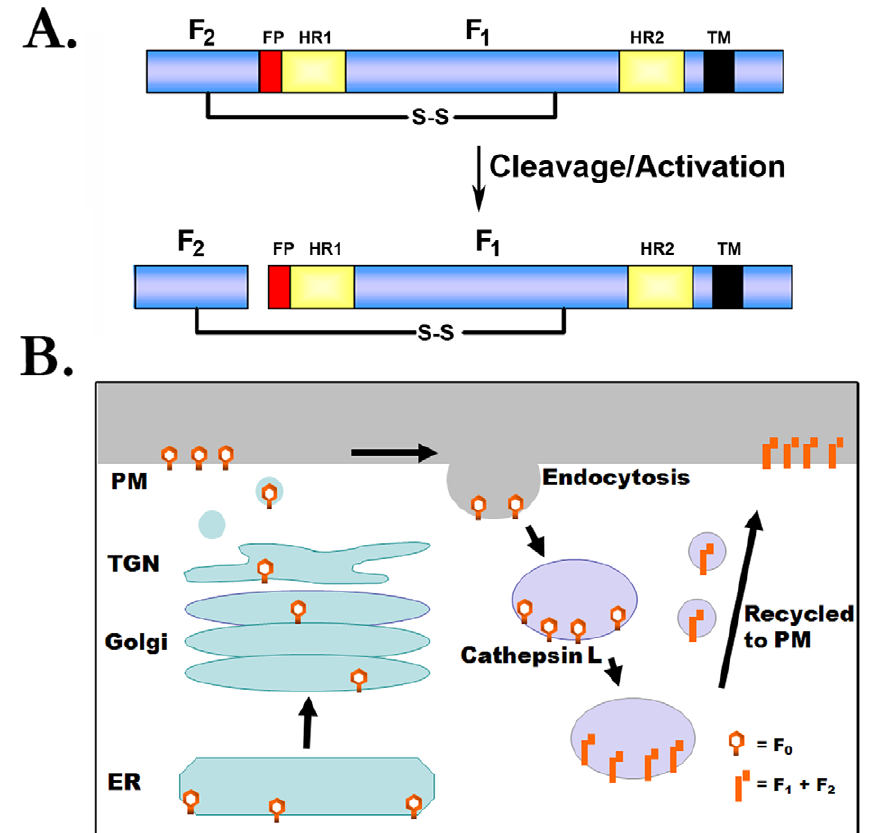
Figure 2. Proteolytic processing of the henipavirus fusion proteins. (A) Schematic of F protein cleavage/activation. FP, fusion peptide; HR1 and HR2, heptad repeat; S-S, disulfide bond; TM, transmembrane domain. (B) Model for proteolytic processing of the henipavirus F proteins. The Hendra or Nipah F proteins are synthesized in the endoplasmic reticulum (ER), transit through the secretory pathway to the plasma membrane (PM), and are subsequently endocytosed. Following interaction with cathepsin L at an undetermined point in the endocytic pathway, the cleaved protein is recycled to the plasma membrane.